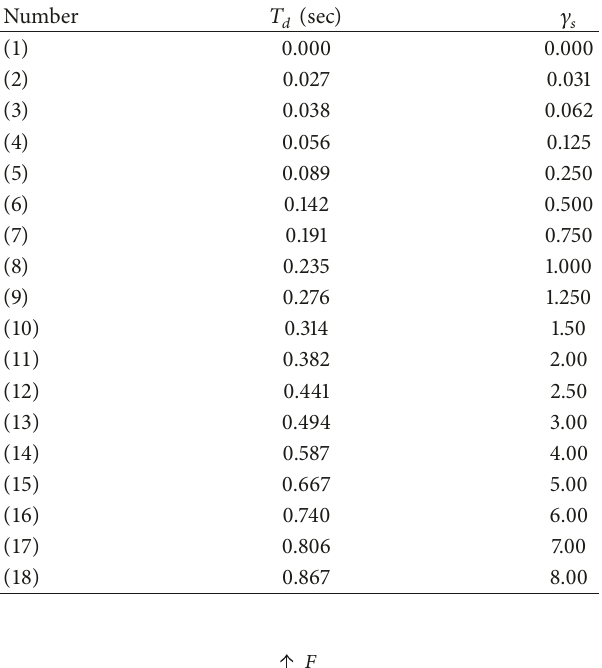
Table 4: Natural periods of individual diaphragms and correspond- ing values of flexibility in base symmetric structure.